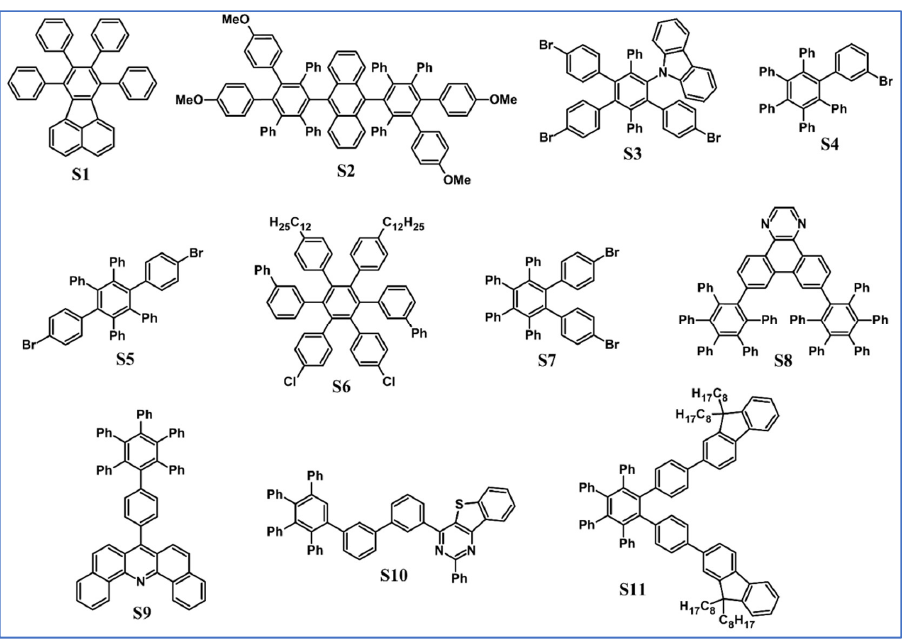
Figure 1. Patented polyarylbenzenes obtained via DA cycloaddition with CO extrusion (appropriate